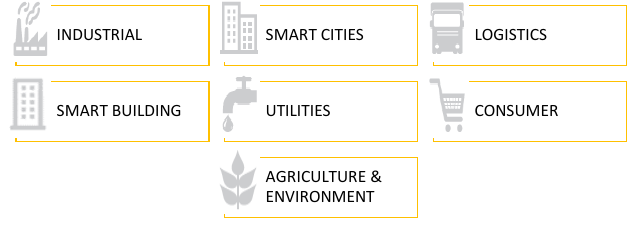
Figure 9: LPWA applications